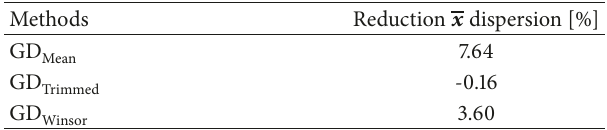
Table 32: Exponential with 100 points.